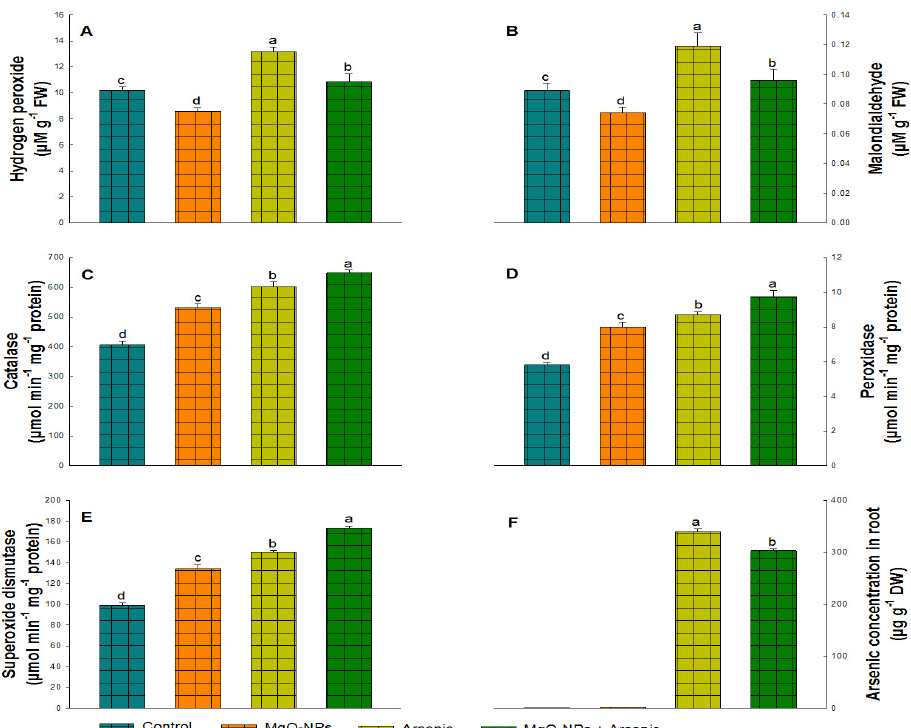
Figure 3. Hydrogen peroxide (H 2 O 2 ) ( A ), malondialdehyde (MDA ( B ), catalase (CAT) ( C ), peroxidase (POD) ( D ), superoxide dismutase (SOD) ( E ) and arsenic (As) content ( F ) of soybean plants before and after foliar spray with MgO-NPs in the presence/absence of As. Error bars represent standard deviation and different letters indicate significant differences at p < 0.05.